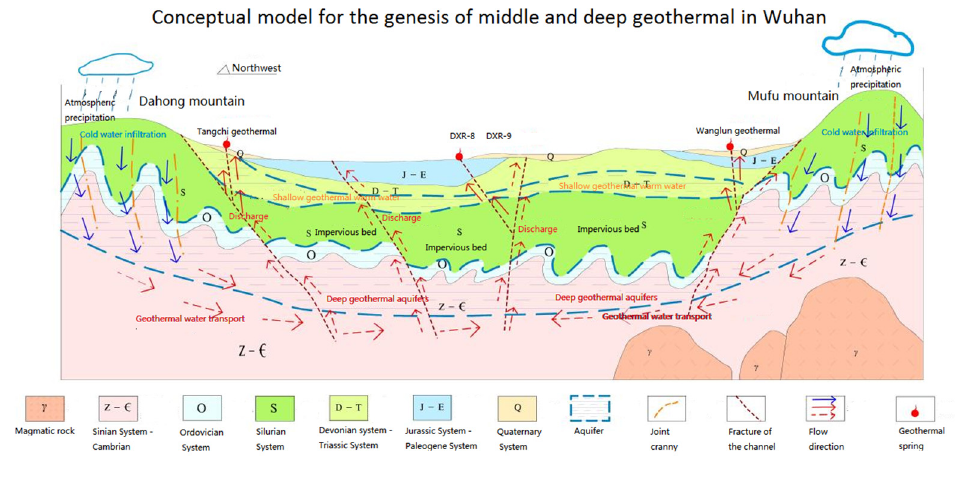
Figure 8. Conceptual model diagram of deep and shallow geothermal genesis in Wuhan.